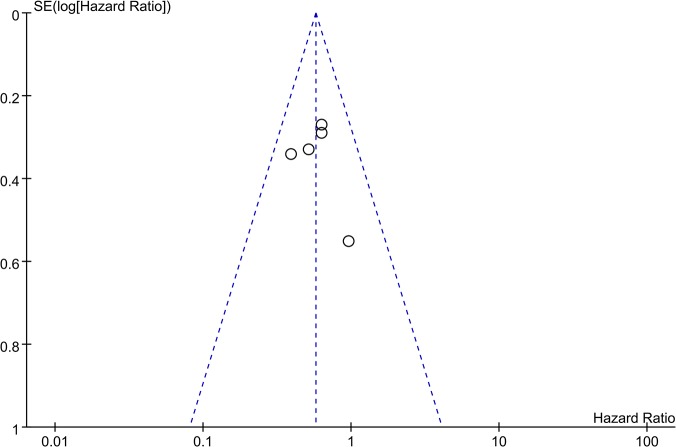
Funnel plot of meta-analysis assessing TIMP-2 expression in patients with NSCLC.Funnel plots were constructed to examine publication bias of all included researches.